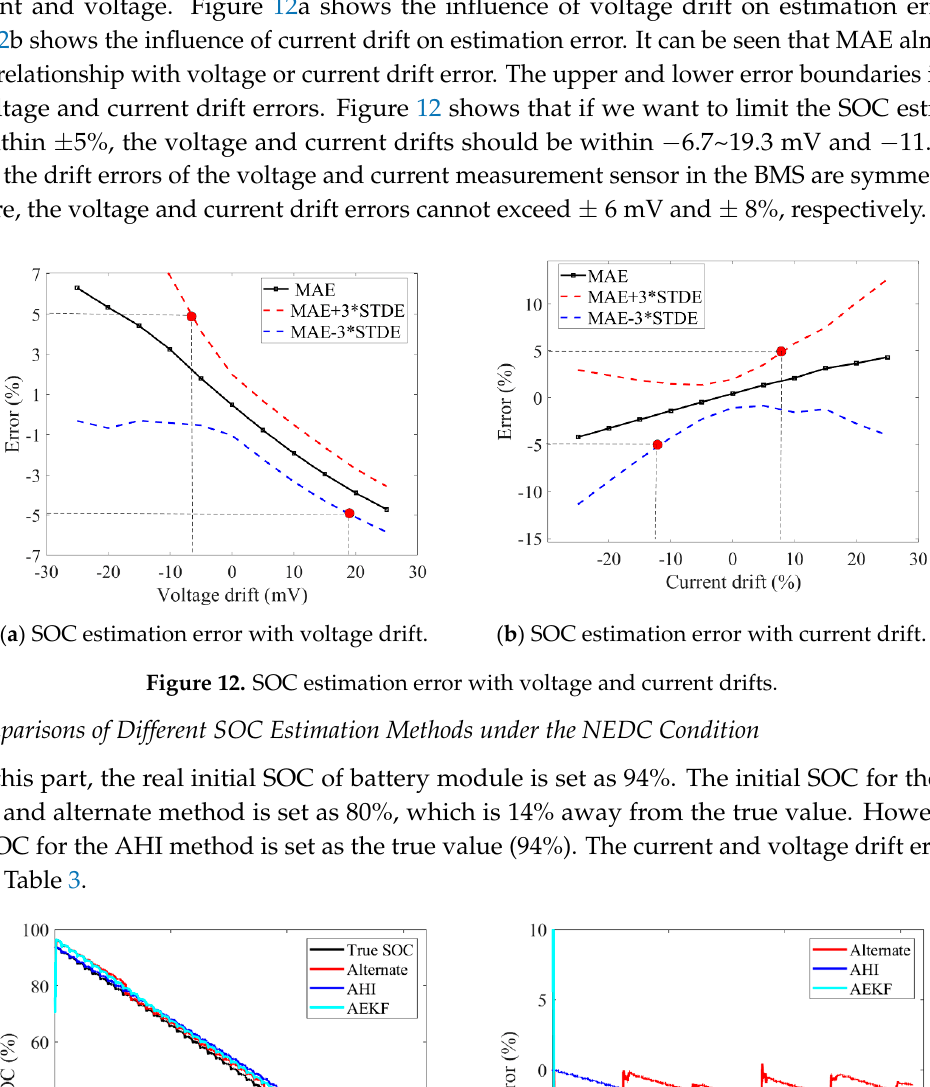
Table 4. SOC estimation errors and the time cost using different methods with voltage drifts and current